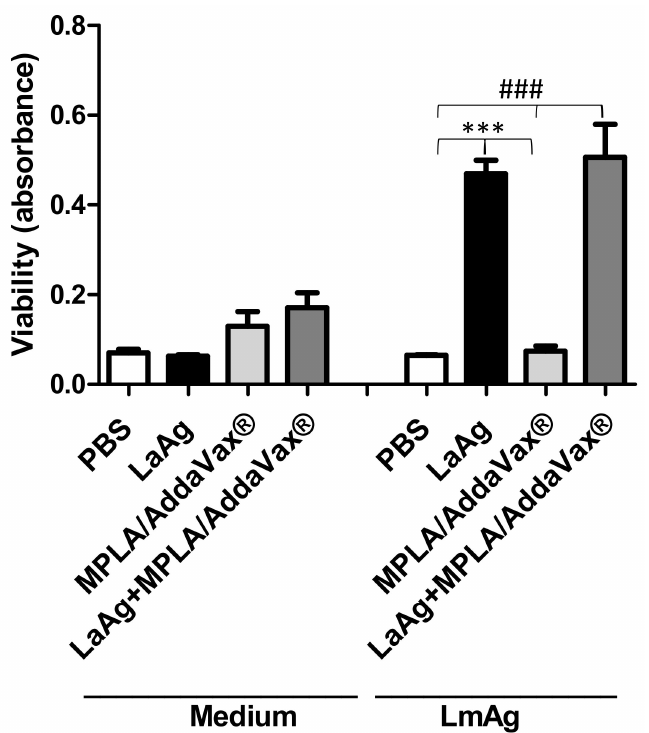
Figure 3. Immunization of LaAg with MPLA plus AddaVax ® induced proliferation of immune cells similar to those immunized with LaAg alone. Cells from the lymph node draining of the lesion of C57BL/6 mice immunized or PBS-injected were removed 72 h after infection with 2 × 10 5 L. amazonensis stationary phase promastigotes. Single cell suspensions (1 × 10 6 ) were stimulated with 10 µ g/mL L. major antigen (LmAg) or medium as a control. Data are representative of two independent experiments (mean ± standard deviation; n = 5) *** p < 0.0001 in relation to cells from the LaAg-immunized group stimulated with LmAg and ### p < 0.0001 in relation to cells from the LaAg+MPL/Addavax ® -immunized group stimulated with